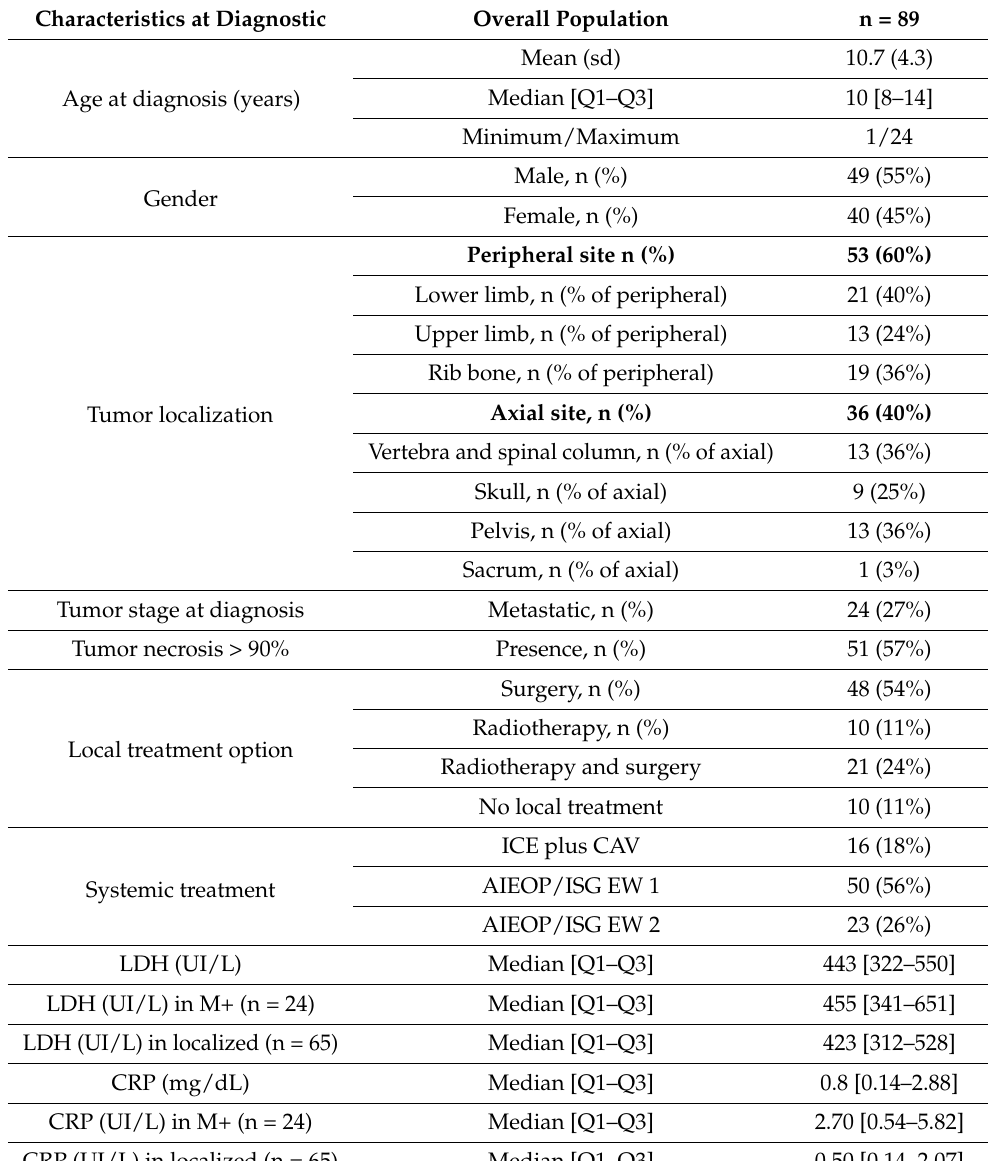
Table 1. Clinical characteristics of the overall